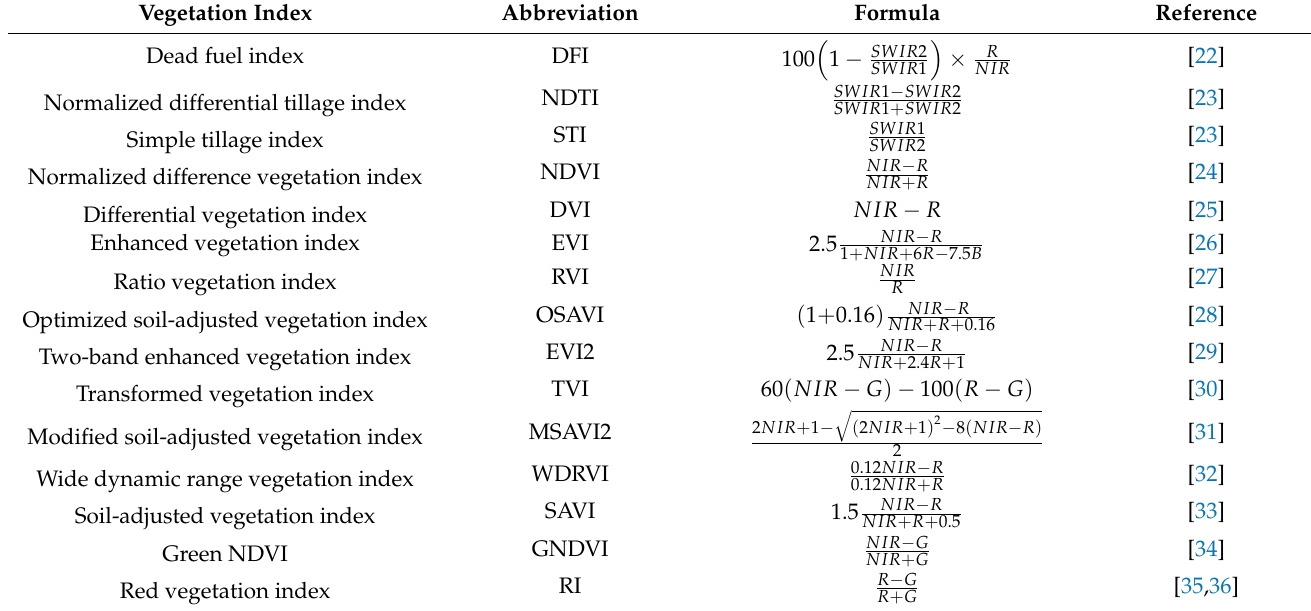
Table 3. Spectral